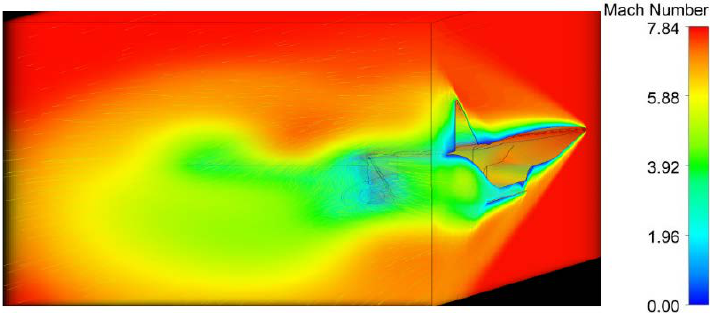
Figure 30. Mach streamlines, contours, and volume of the proposed aircraft at Mach 8.